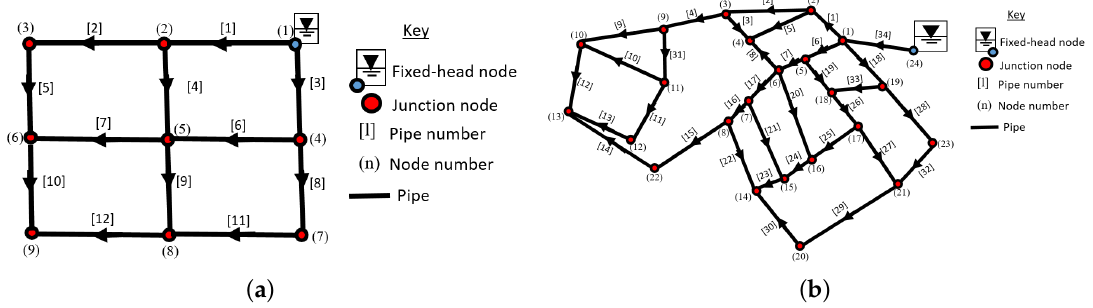
Figure 1. The schematics of the case study networks used for the numerical examples: ( a ) network 1; ( b ) network